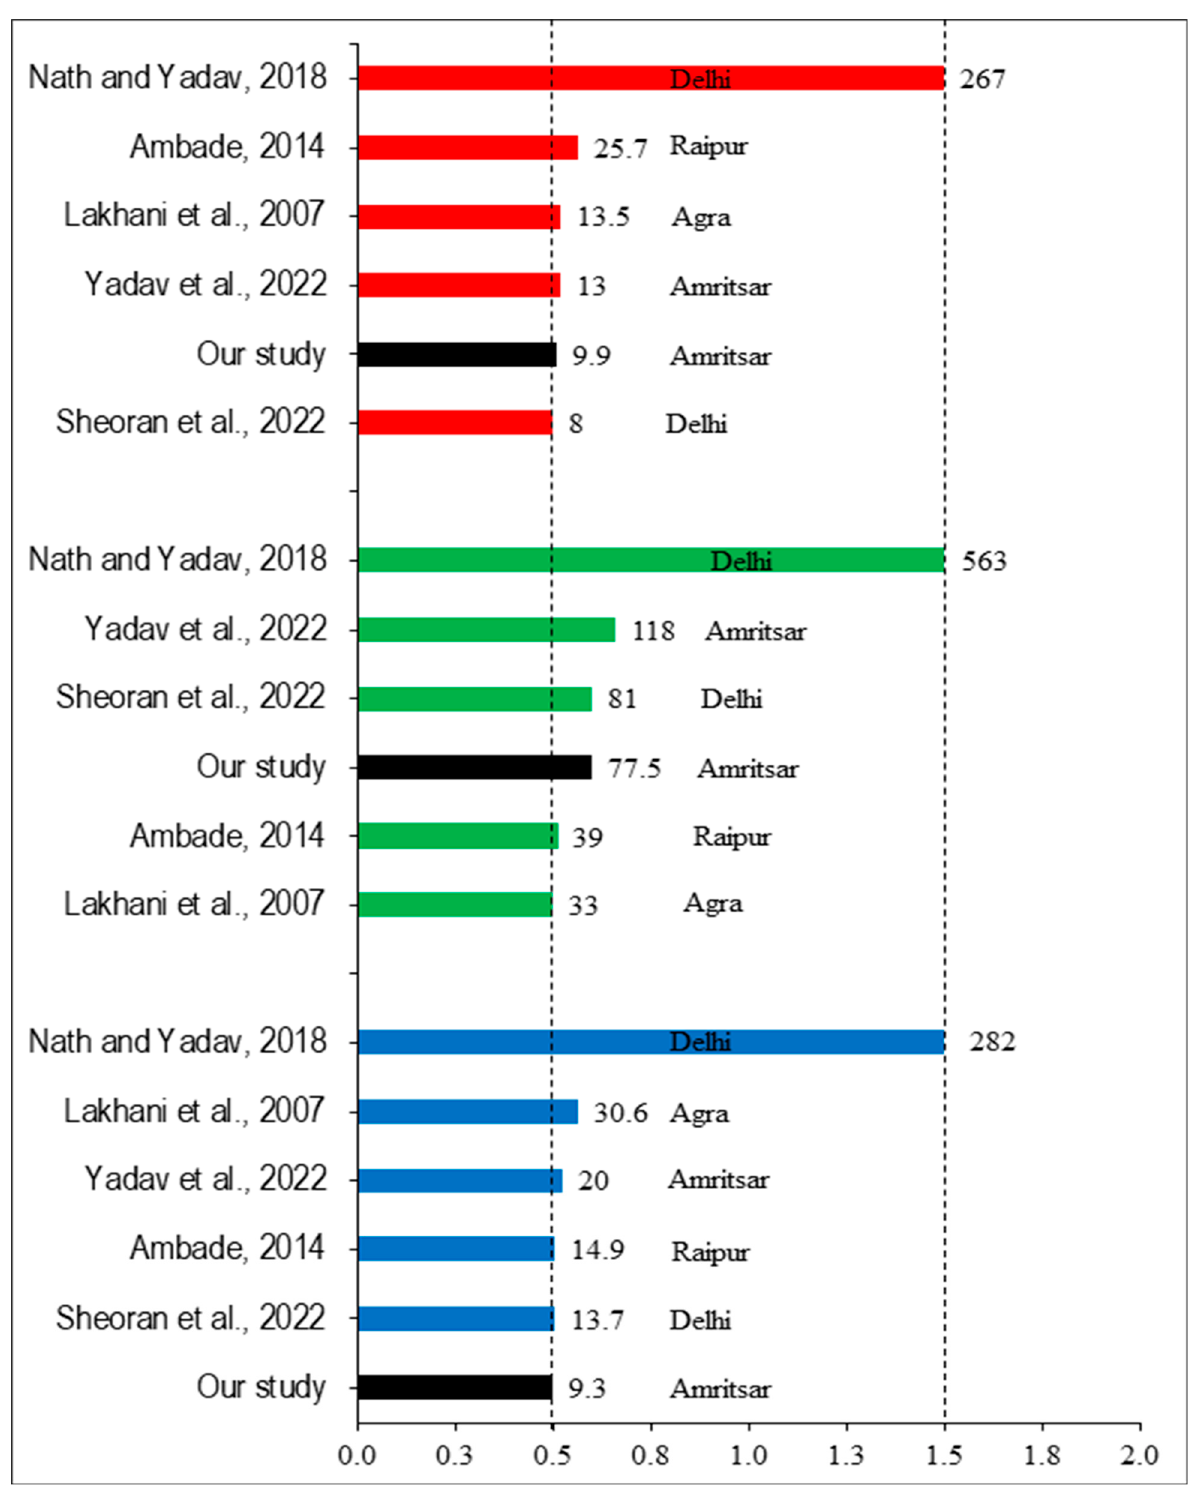
Figure 4. Review graph of anionic concentration (mg/L) on normalized scale (0.5–1.5) for chloride (red), sulphate (green) and nitrate (blue) in fog water studies, (Black color represent own study). References included are [23,33,39,40,51].